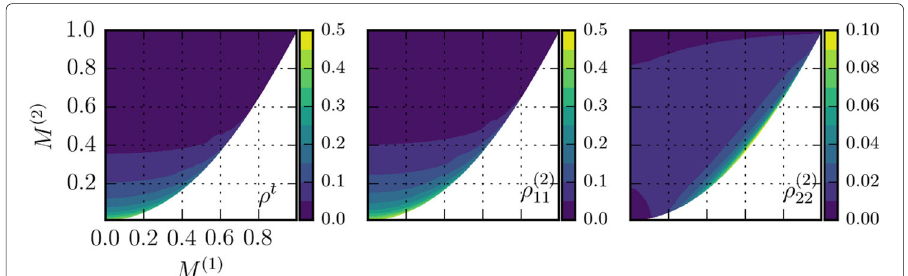
Fig. 13 Cross slip annihilation functions of ρ , ρ ( 2 ) 11 and ρ ( 2 ) 22 in CDD ( 2 ) for a DODF symmetric around screw orientation ( ϕ ρ = 0). For this symmetry angle M ( 1 ) = ρ 1 /ρ and M ( 2 ) = ρ 11 /ρ . Bimolecular annihilation corresponds to the upper limit of M ( 2 ) =